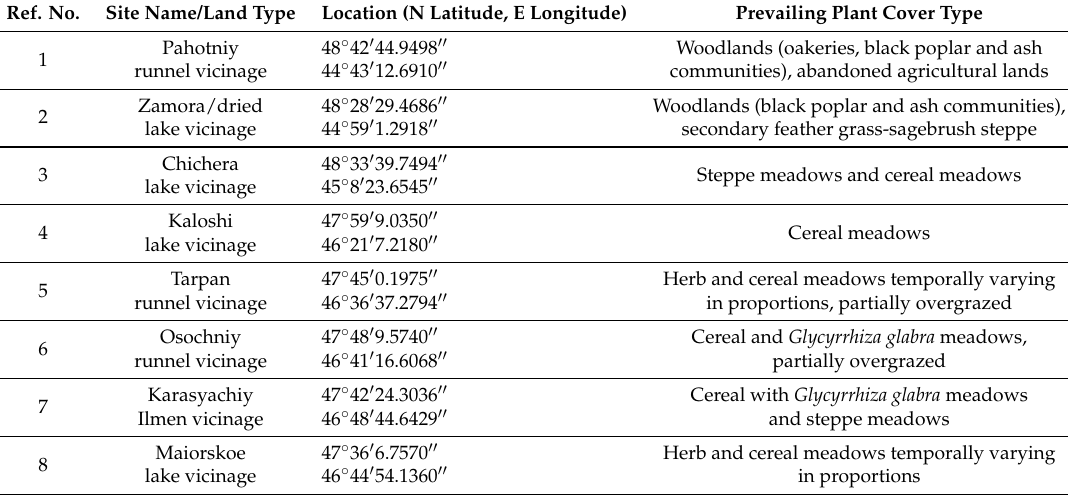
Figure 1. Test sites under study: wetlands, deserts and dry steppes. Table 1. List of test